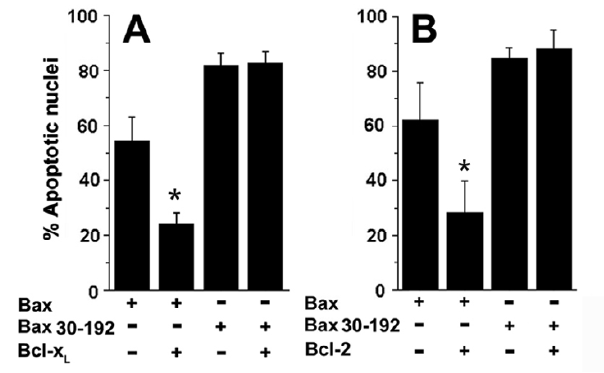
Table 1: Percent viability with tissue specific GAL4 drivers